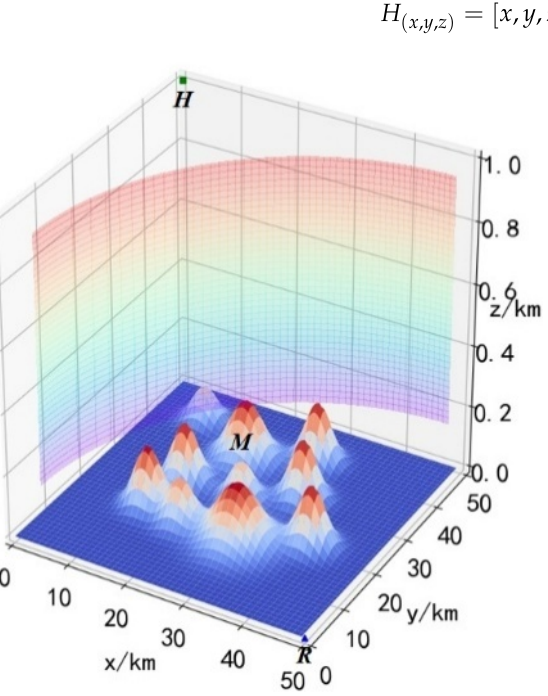
Figure 1. Battlefield environment. The colored curved surface is the radar detection boundary.